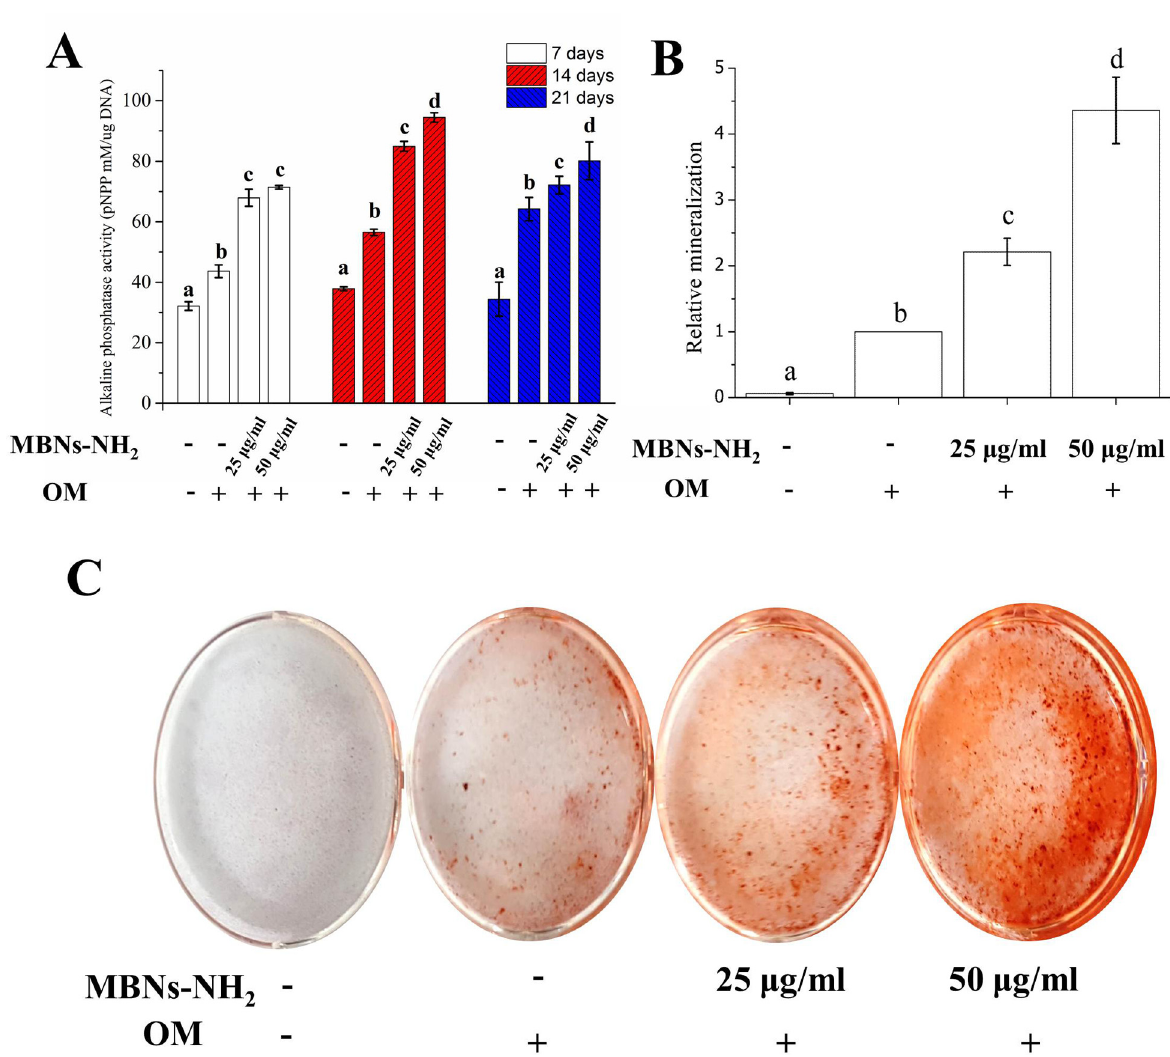
Fig 6. Effects of MBNs-NH 2 in rDPSCs on alkaline phosphatase (ALP) activity (at 7, 14, and 21 days) ( a ) and on calcium deposition using alizarin red staining (ARS) (at 28 days) ( b and c ). After ARS was observed under the microscope ( c ), 10% w/v of cetylpyridinium chloride monohydrate was used for quantitative analysis ( b ). Cells were incubated for 7 to 28 days in odontogenic supplemental medium (OM). Different letters indicate significant differences among them at p < 0.05. The measurements were performed in triplicate, and representative average (n = 5) with SD or images are